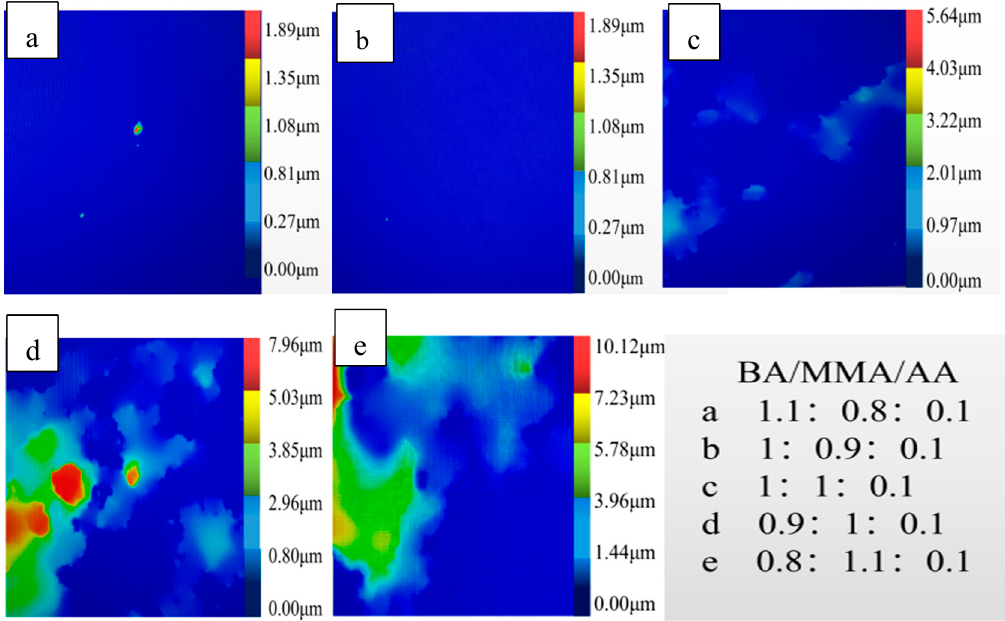
Figure 5. Scan images of samples on different surfaces.